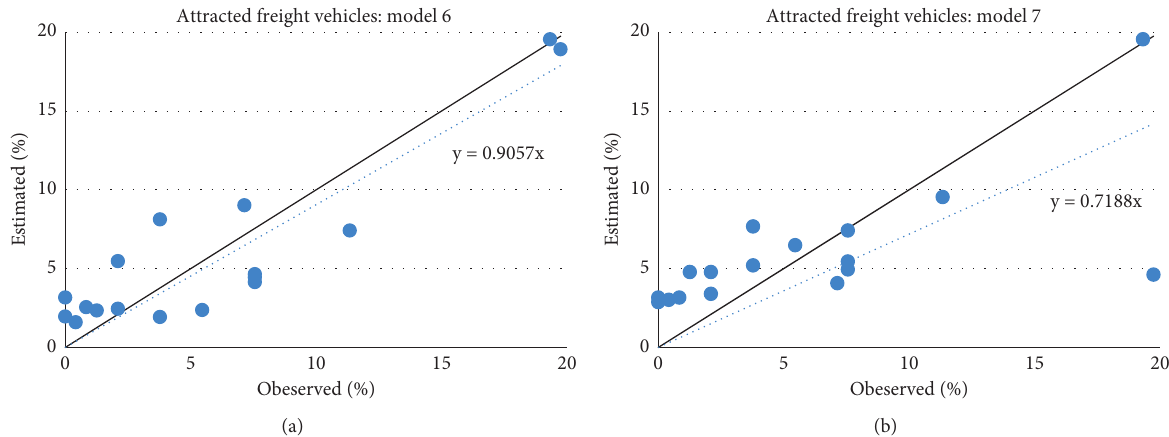
Figure 7: Comparison between observed and estimated values of attracted freight vehicles. Scatterplots for model 6 (a) and model 7 (b).